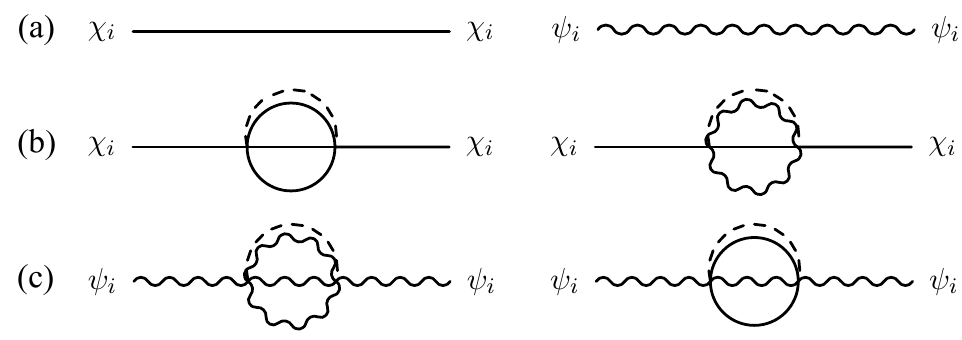
Figure 1 . (a) Left: the Green’s function G (cid:31) ( (cid:28) ) of SYK (cid:31) ; right: the Green’s function G ( (cid:28) ) of SYK . (b) Order of N for self energy diagram of (cid:31) : left: (cid:24) J 2 ( N 2 ) 2 (cid:24) O ( N 0 ). The dashed line means the two vertices should have same coupling. (c) Order of N for self energy diagram of : left: (cid:24) J 2